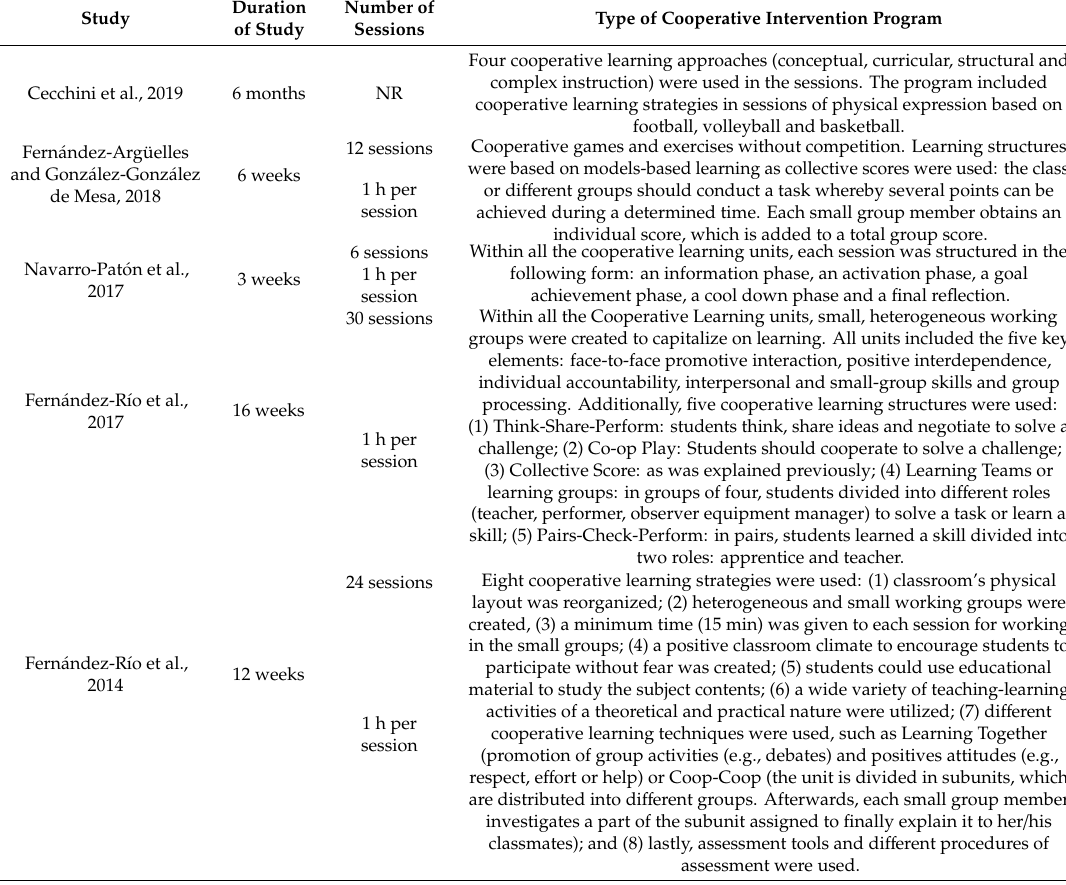
Table 3. Characteristics of the interventions (duration and